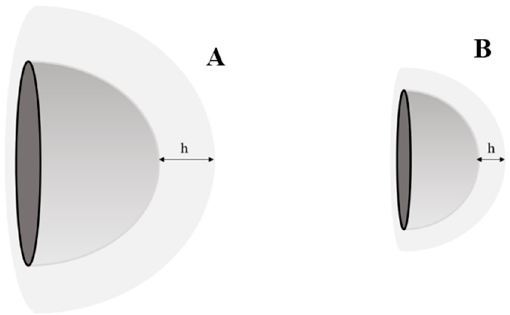
Figure 1. Comparison of Diffusional Distance of a ( A ) Microcrystal and a ( B ) Nanocrystal.